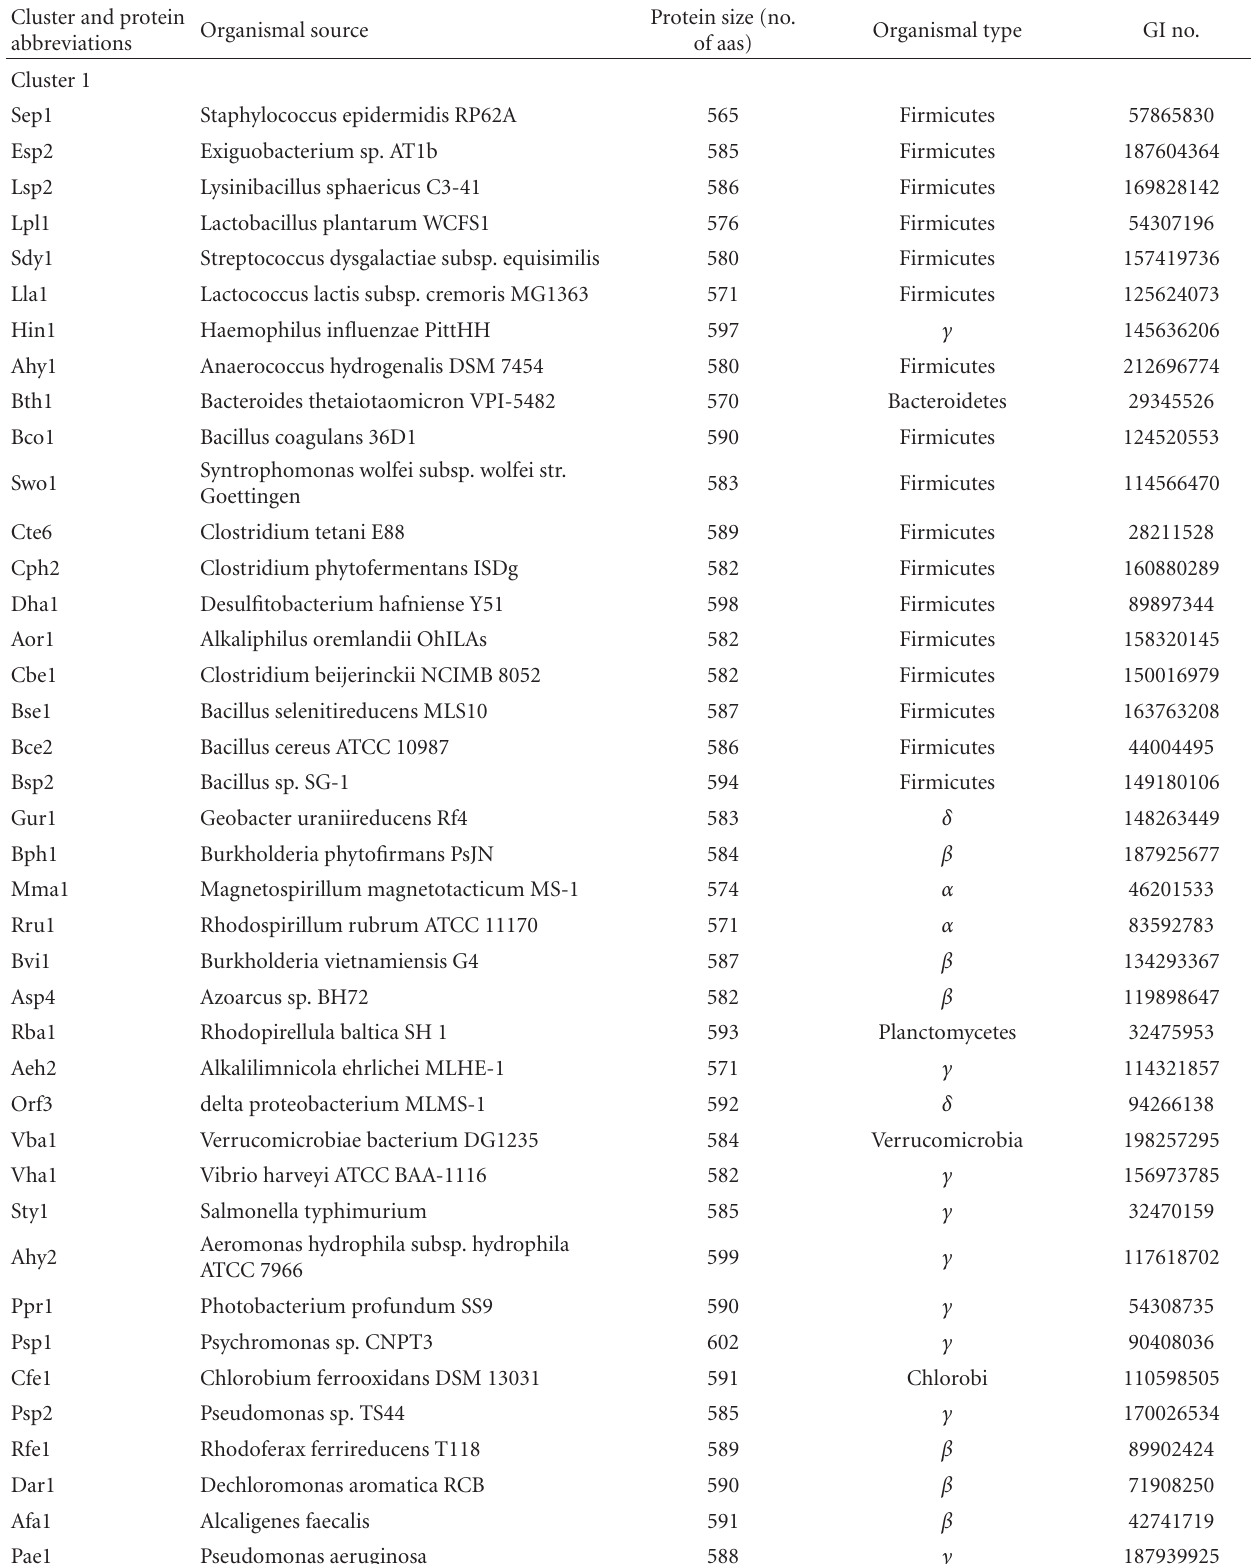
Table 1: ArsA homologues used to generate the phylogenetic tree. From left to right, the proteins are characterized according to cluster and abbreviation, organismal source, protein size, organismal type, and gi number. Within each cluster, proteins are presented according to position going clockwise around the